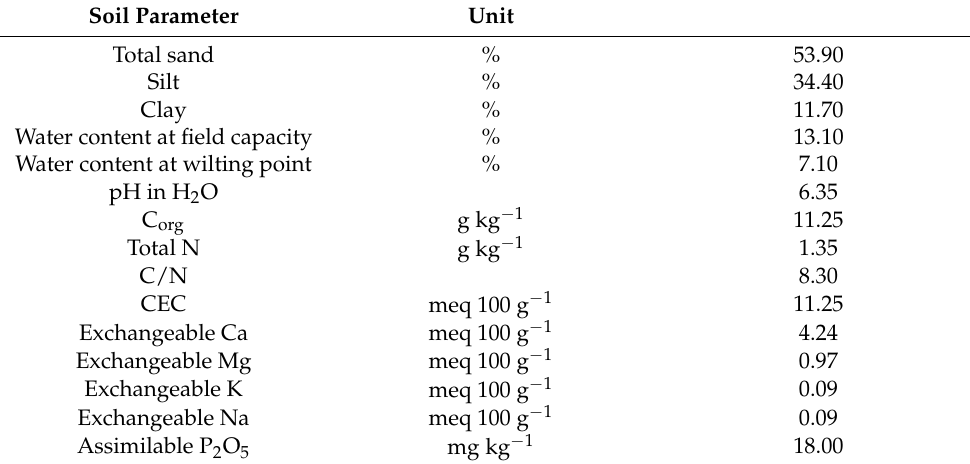
Table 1. Soil properties of the experimental field at the beginning of the trial (T 0 ). Soil